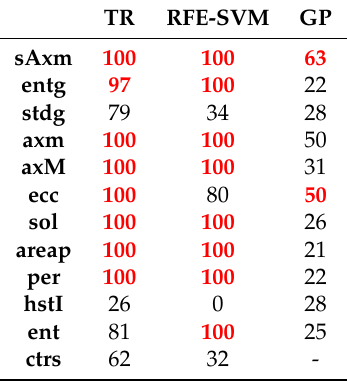
Table 5. The individuals of the population pool used to build the ensemble of binary classifiers defined in Equation (6).